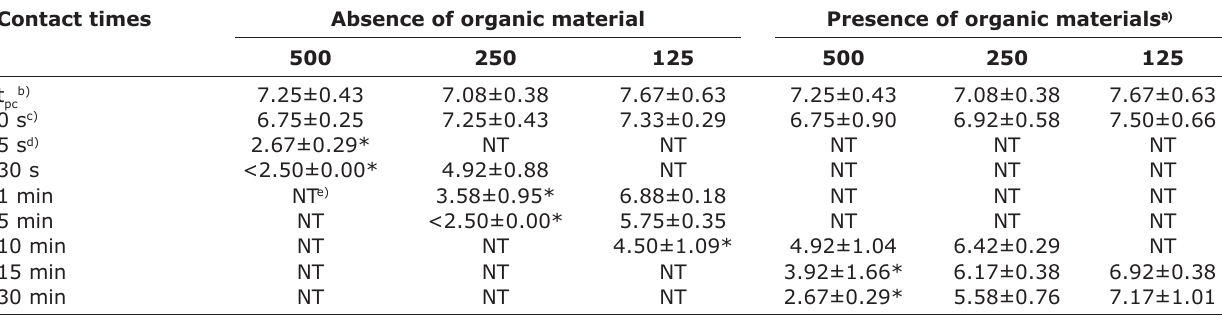
The results are presented as log TCID /ml (mean±SD) of AIV inactivating activity at room temperature using DDAB 10 50 as 500, 250, and 125 ppm in the absence or presence of organic materials. a) Fetal bovine serum was added to DDAB solution as 5% organic materials of total volume. b) The titer converted into an index in log of virus control. c) Added 10 blocking solution before AIV. d) The titer converted into an index in log of the recovered virus after indicated time 10 of treatment such as 5 s, 30 s, 1 min, 5 min, 10 min, 15 min, and 30 min. e) NT=Not tested, *Inactivation effective when RF was ≥3. DDAB=Didecyl dimethyl ammonium bromide, CFU=Colony‑forming units, SD=Standard deviation,